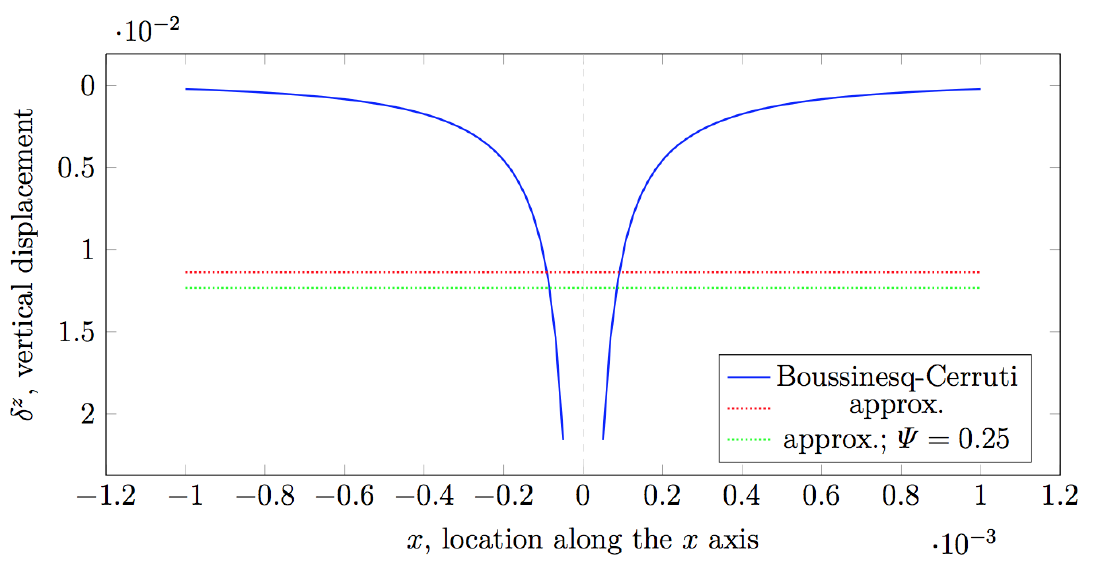
Figure 2. Singularity of the Boussinesq–Cerruti solution. The solution is presented along the x axis with y = z = 0, for a force F z = 1 N, elastic modulus E = 2.1 × 10 5 Pa, robot skin thickness h n = 2 mm, and size of the grid cell dx = dy = 0.2 mm. It is noteworthy that the theoretical displacement at x = y = z = 0 is